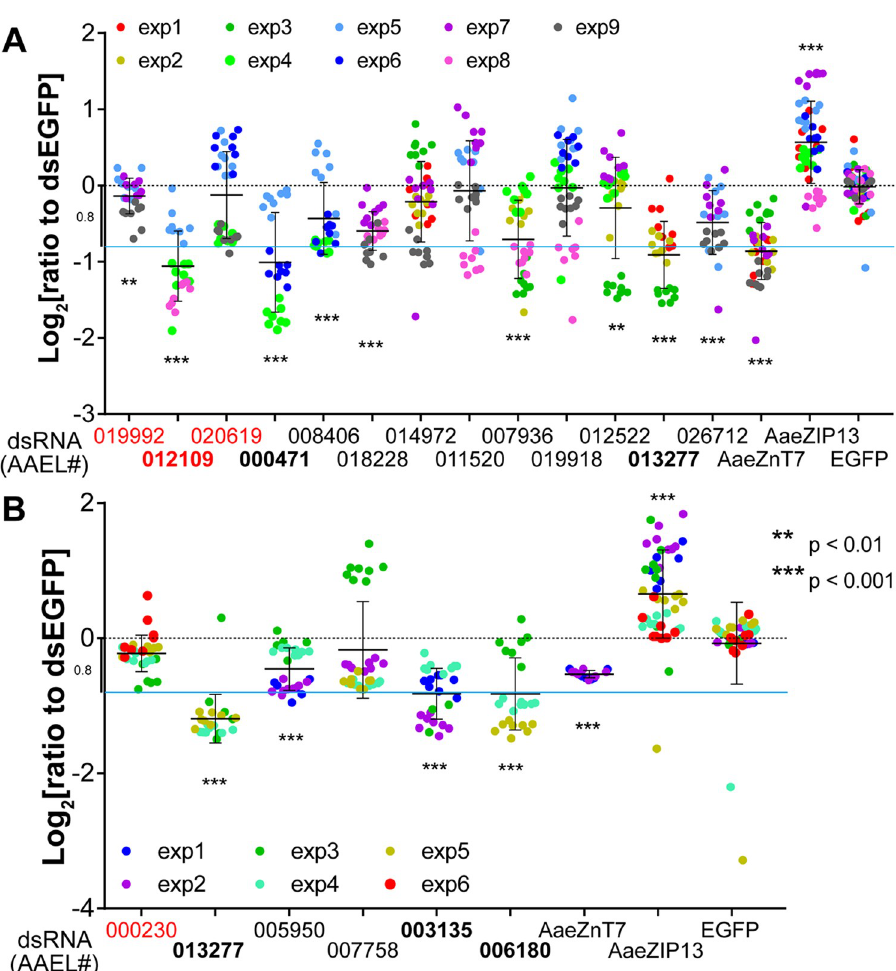
Fig 3. RNAi knockdown of candidate iron transporters changes iron-responsive reporter expression in mosquito cells. (A) Dual-luciferase assay in Aag2 cells and (B) in A20 cells. Normalized firefly luciferase luminescence values (to EGFP control) are plotted on a Log 2 scale with mean ± SD. Different dot colors indicate individual experiments. Neutral level is indicated by a black dotted line; sky-blue line indicates manually set cutoff ( − 0.8log 2 ) for downstream analysis. The targets of dsRNA (either VectorBase gene ID [AAEL number] or gene name) are on the x axis. The predicted exporters are indicated by red fonts and the five genes selected for downstream analyses are in bold fonts. Statistical significance by mixed effect model (see methods) between EGFP control and each sample are shown in the